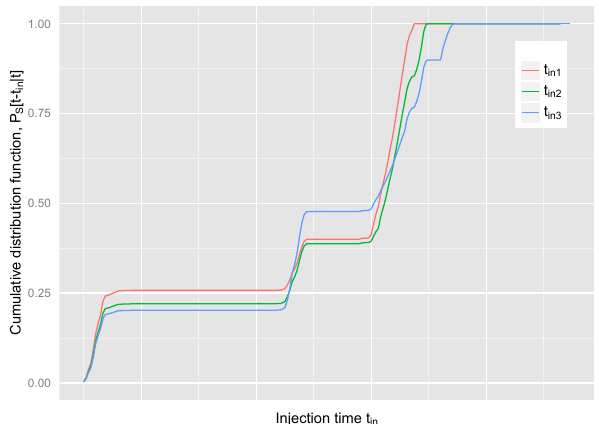
Figure 3. Representation of the backward cumulative distribution function for three injection times ( t in , where i = 1, 3) as varying i with the actual time t . The time shift between the three injections was dropped for a direct comparison of the curves.